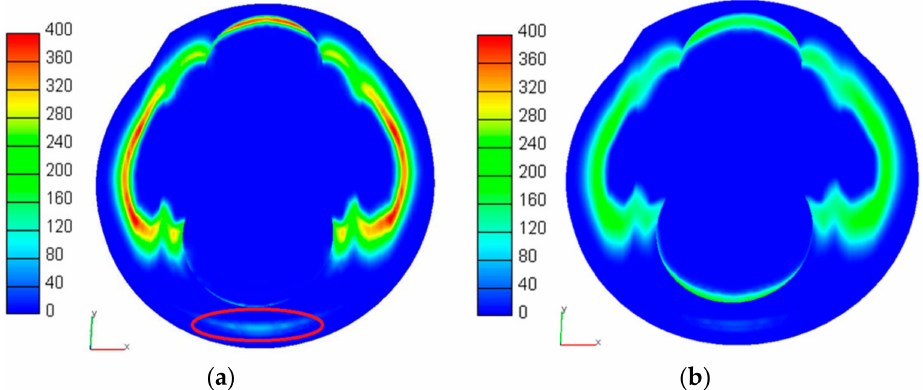
Figure 11. Comparison of reaction rates (kg / m 3 / s) when flames travel at the same distance: ( a ) 1% EGR (TDC); ( b ) 10% EGR (10 ◦ CA